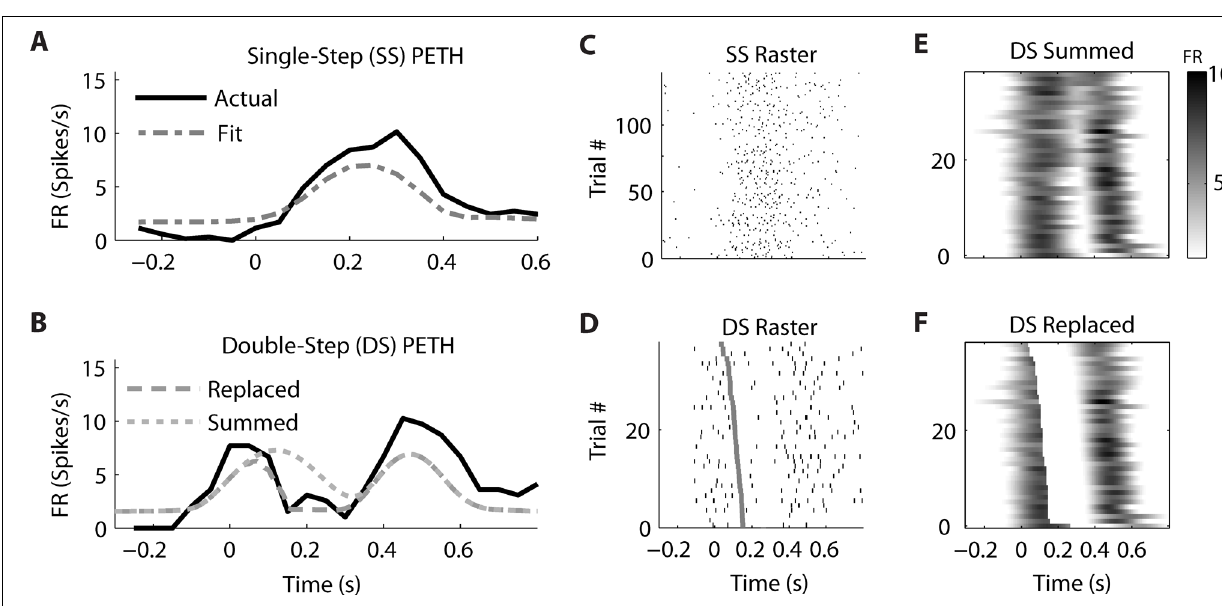
FIGURE 8 |A neuron from dorsal premotor cortex is better fit by the “Replaced” hypothesis. Format follows Figure 5 .